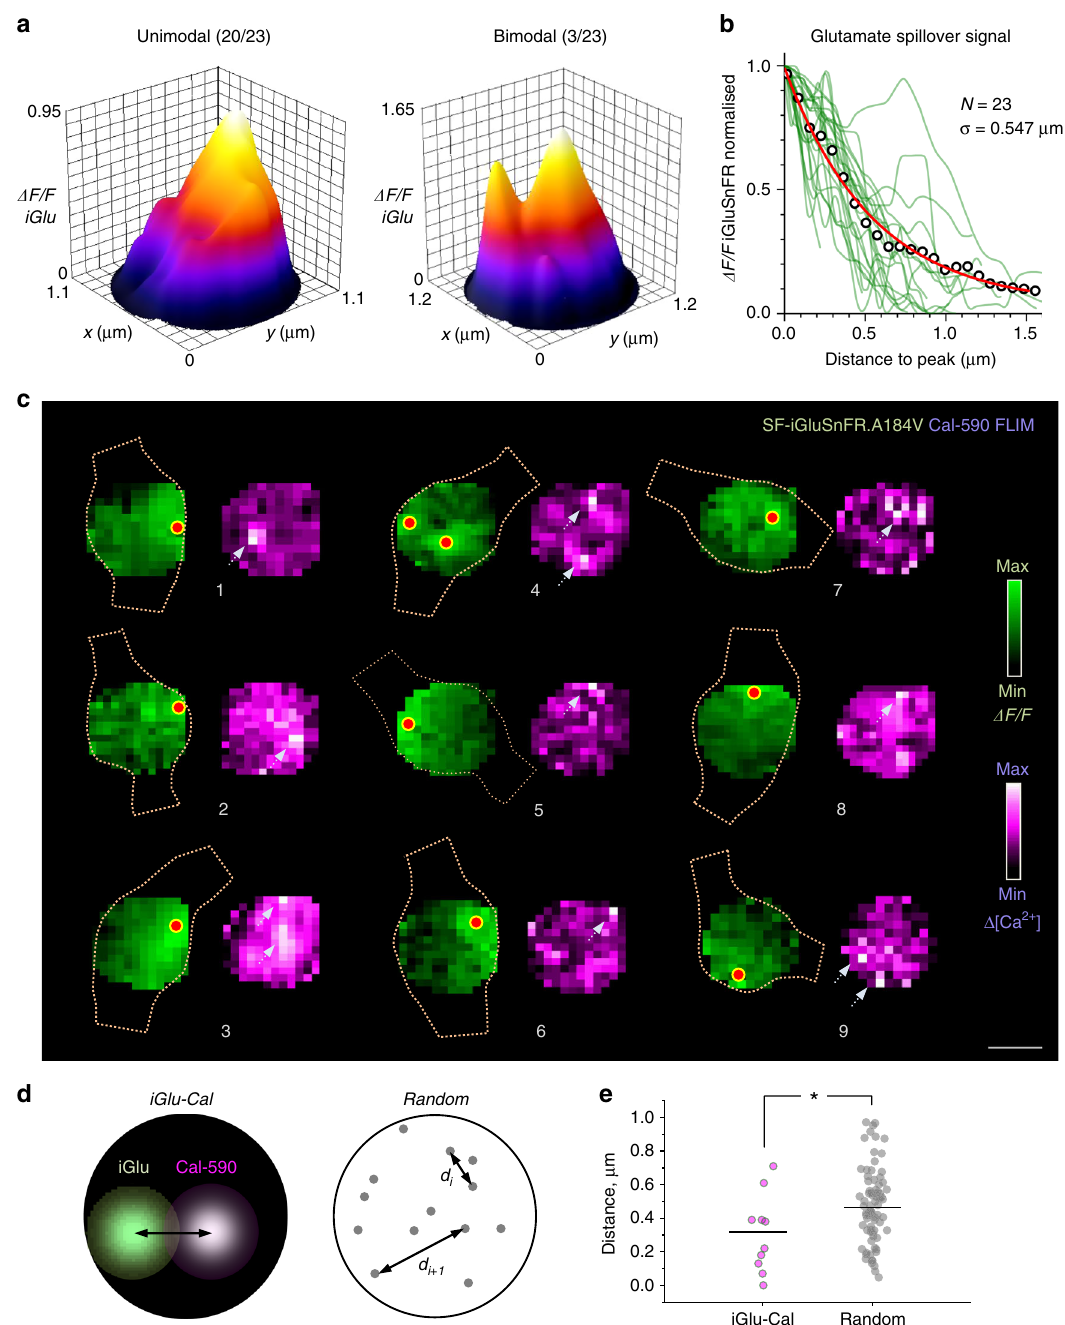
Fig. 7 Evaluating sub-microscopic glutamate signal spread and co-localisation of glutamate release and presynaptic Ca 2 + entry in presynaptic boutons. a Examples of unimodal (left, 20/23 boutons) and bi-modal (right, 3/23 boutons) spatial pro fi les of the SF-iGluSnFR signal intensity (20-22 trial average) upon glutamate release, as seen in the focal plane; averaging spatial fi ltering (~100 nm range) applied; peaks point to the most likely release site location. b Spatial decay of the fl uorescence signal ( Δ F/F SF-iGluSnFR.A184V) measured in geodesic-corrected heat maps (as in Fig. 6g) for N = 23 individual boutons (green lines); circles, average; solid red line, best- fi t exponent: spatial decay constant σ = 0.547 ± 0.016 µ m (mean ± standard error). c Examples of simultaneously recorded heat maps showing glutamate signal (green, Δ F/F SF-iGluSnFR) and [Ca 2 + ] increment pro fi les (magenta, Cal-590 fl uorescence lifetime imaging microscopic readout upon four action potentials, magenta); dotted shapes, outlines of the recorded axonal bouton pro fi les; red dots, estimated glutamate release site locations; arrows, consistent hotspots of Cal-590 [Ca 2 + ] transients; scale bar, 0.5 µ m. d Diagrams illustrating the measurement of distances between recorded hotspots of glutamate and Ca 2 + signals, as shown in c (left), and between points randomly scattered within a similar circular area (right). e The average distance between recorded hotspots of glutamate and Ca 2 + signals (mean ± s.e.m., 0.308 ± 0.073 µ m, n = 10; grey dots) is signi fi cantly lower than that between randomly scattered points (0.474 ± 0.025, n = 80, orange dots; * p < 0.028, t